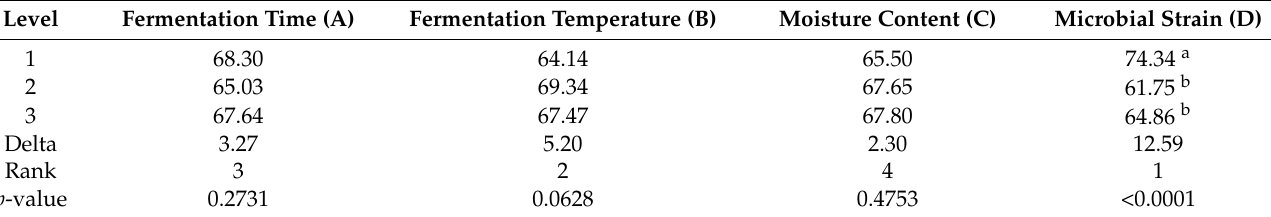
Table 7. Optimal fermentations of FG of TMR with CSM.